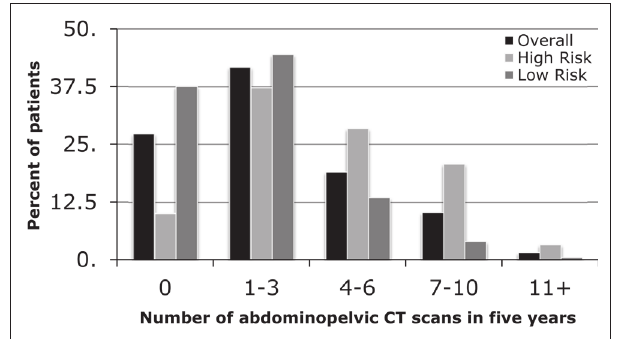
Figure 2) The number of abdominopelvic computed tomography (CT) scans received in the five-year follow-up period, stratified according to high and low risk for recurrence